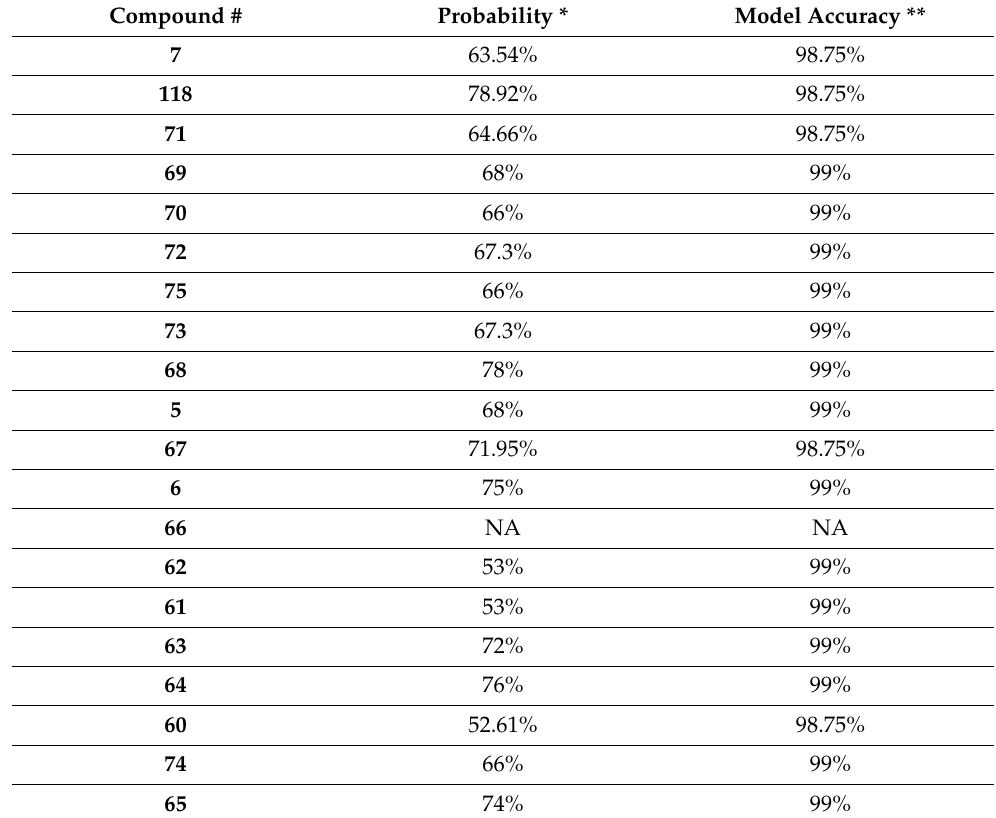
Table 3. The prediction of target probability and model accuracy for phenalenone derivatives against GLUT1, using the SuperPred target prediction web